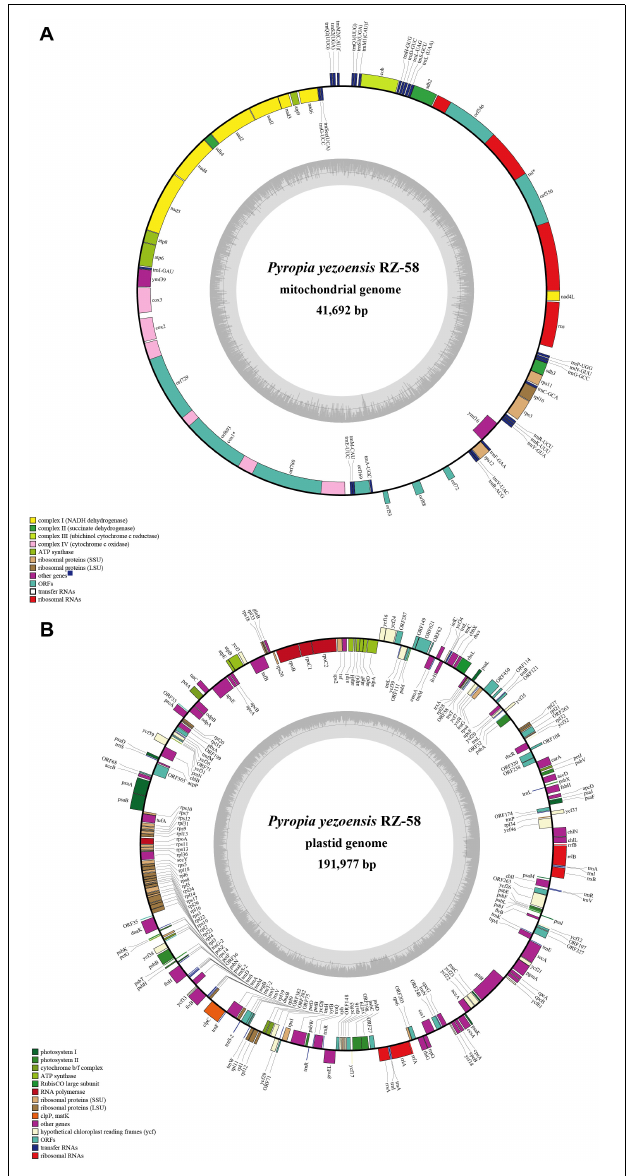
FIGURE 1 | Genome maps of the Pyropia yezoensis mitochondrion (A) and plastid (B) . Genes shown outside the outer circle are transcribed clockwise, and those inside are transcribed counterclockwise. Genes that belong to different functional groups are color coded. The dashed area in the inner circle indicates the guanine–cytosine (GC) content of the organellar